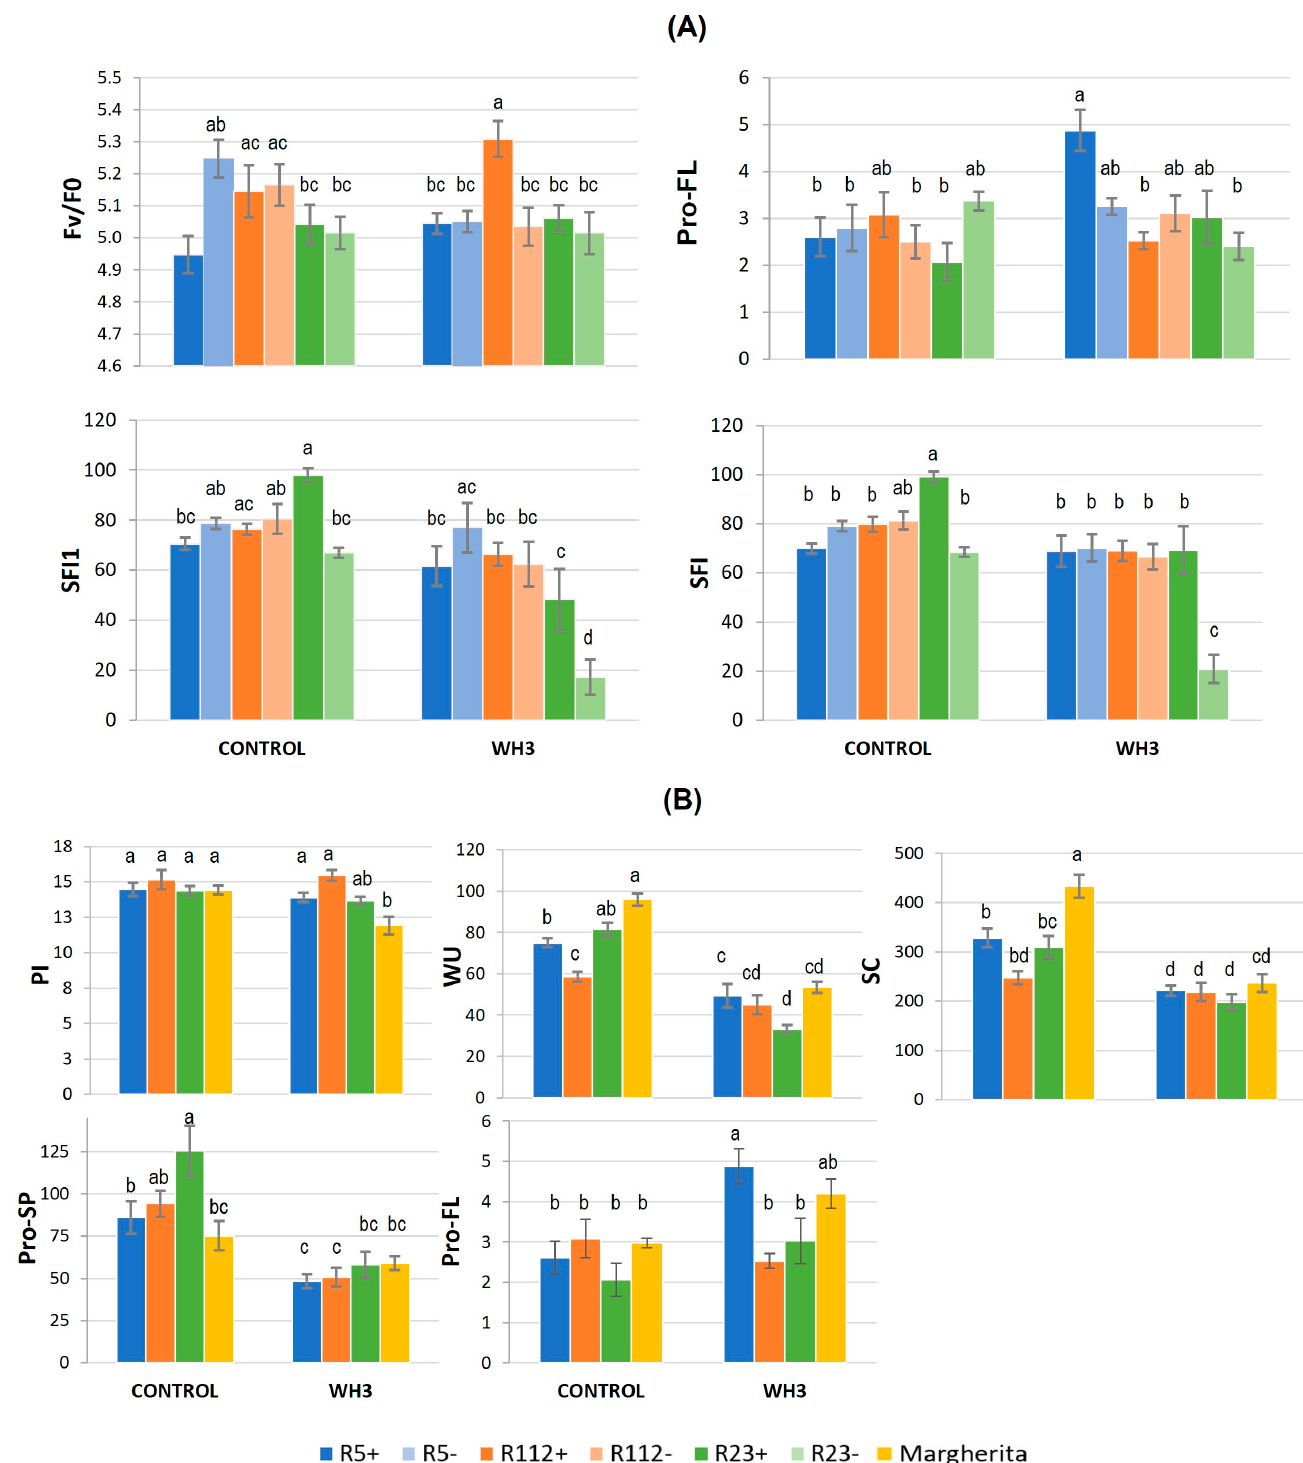
Figure 5 . Significant genotype × treatment effects on physiological and yield-related parameters under combined water-deficit and 3-day heat stress (WH3): ( A ) comparison between alien segment carrier (+) and non-carrier ( − ) NIRLs, and ( B ) comparison between NIRLs+ and cv. Margherita. The error bars represent standard errors of the means, while the letters above the histograms correspond to the ranking of Tukey HSD test at p < 0.05 significance level. For trait acronyms, see the Materials and Methods section.